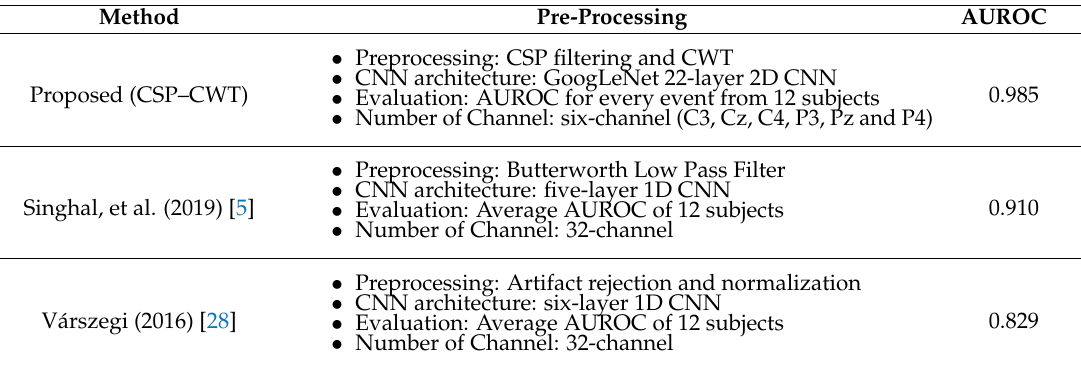
Table 2. Performance comparison of classification of six motor events using the GAL dataset [34] based on the area under ROC